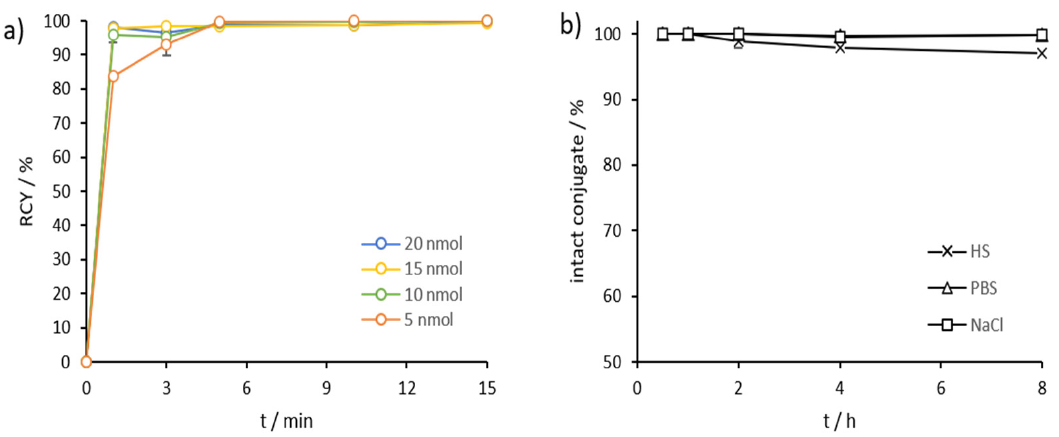
Figure 4. ( a ) Kinetics of [ 44 Sc]Sc-AAZTA 5 .SA.FAPi at RT for tracer amounts ≥ 5 nmol ( n = 3 for 10; n = 1 for 5, 15, and 20 nmol); ( b ) Stability of [ 44 Sc]Sc-AAZTA 5 .SA.FAPi at 37 °C in HS, PBS, and NaCl over a period of 8 h ( n = 3).